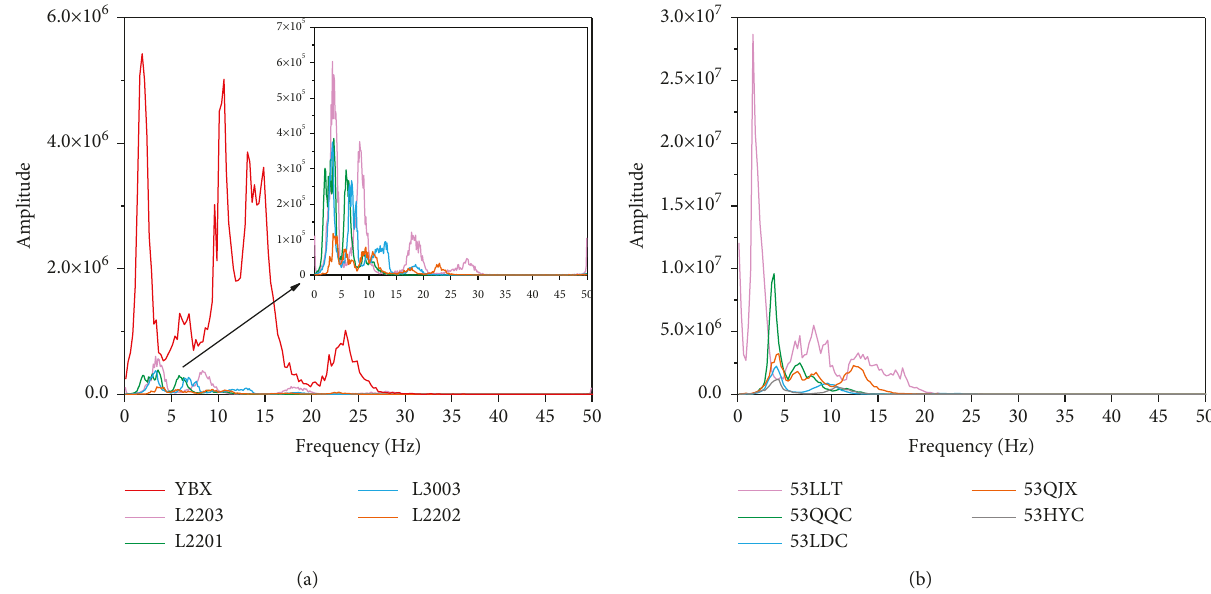
Figure 14: Marginal spectrums of seismic wave in Yangbi earthquake and Ludian earthquake. (a) Yangbi earthquake. (b) Ludian earthquake.